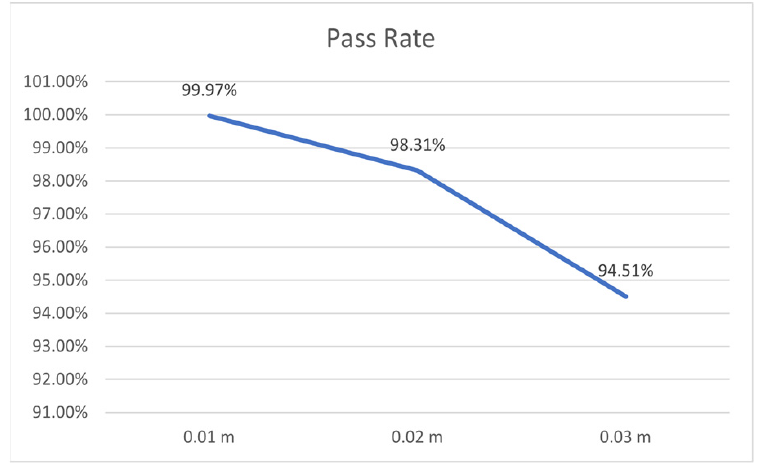
11 of 14 Table 3. Statistics of Seeding Qualification Rate. Traction Speed